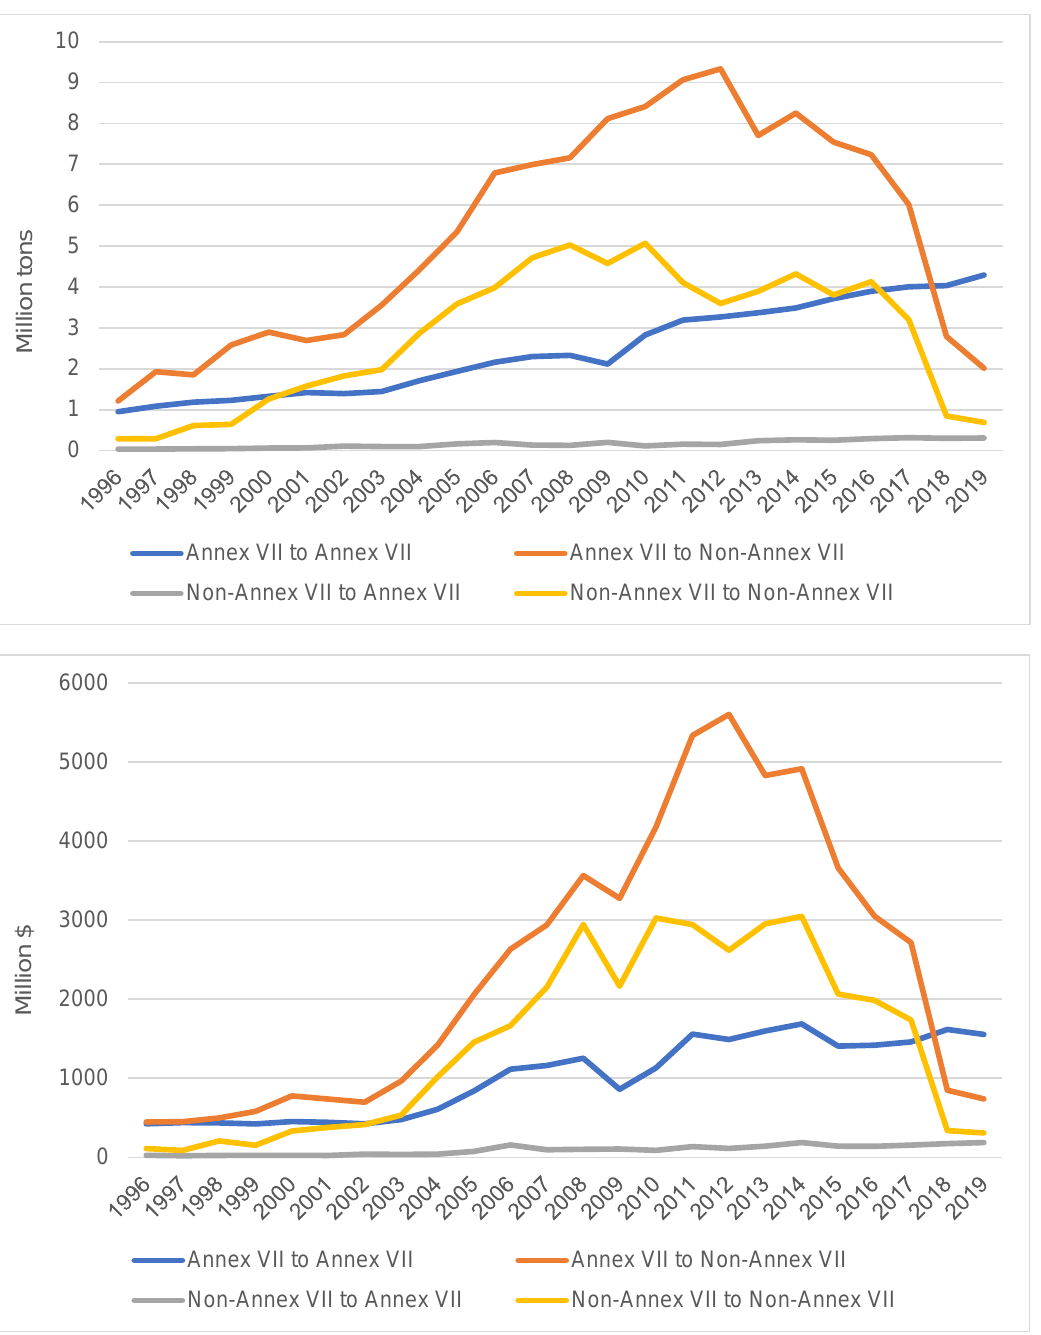
Figure 2. Trade flows of plastic waste by weight ( top ) and by value ( bottom ). Note: Annex VII countries consist of EU and OECD members as well as Liechtenstein; non-Annex VII countries include all other signatories to the Basel Convention.